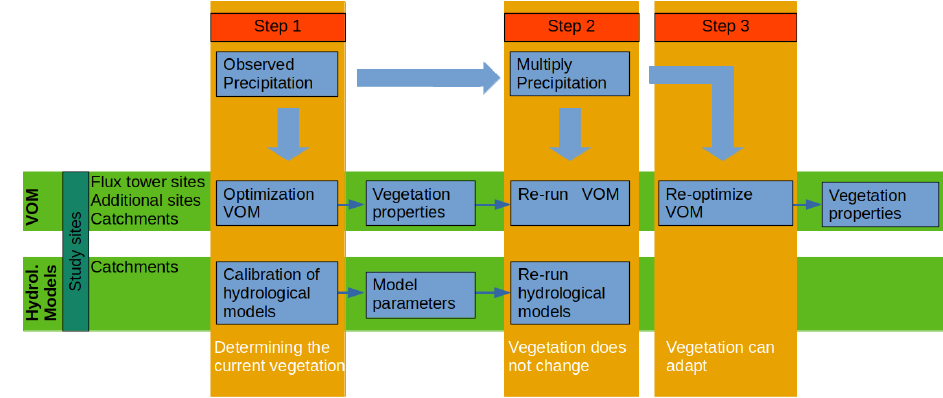
Figure 2. Flow chart of the experimental design, see description Sect.